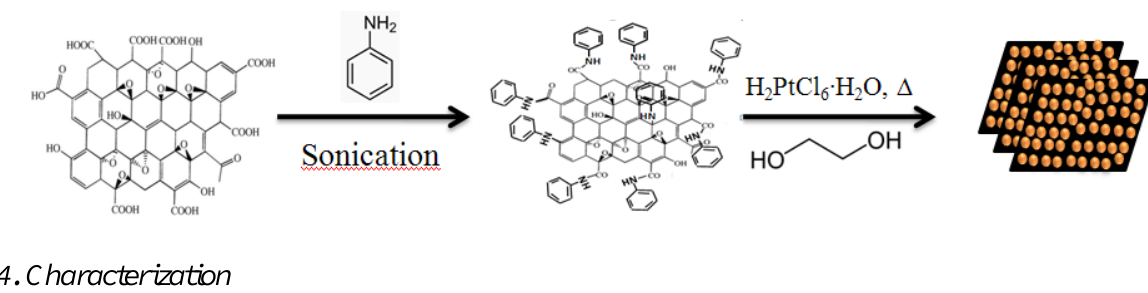
Figure 9. Synthesis of functionalized r-GO/Pt